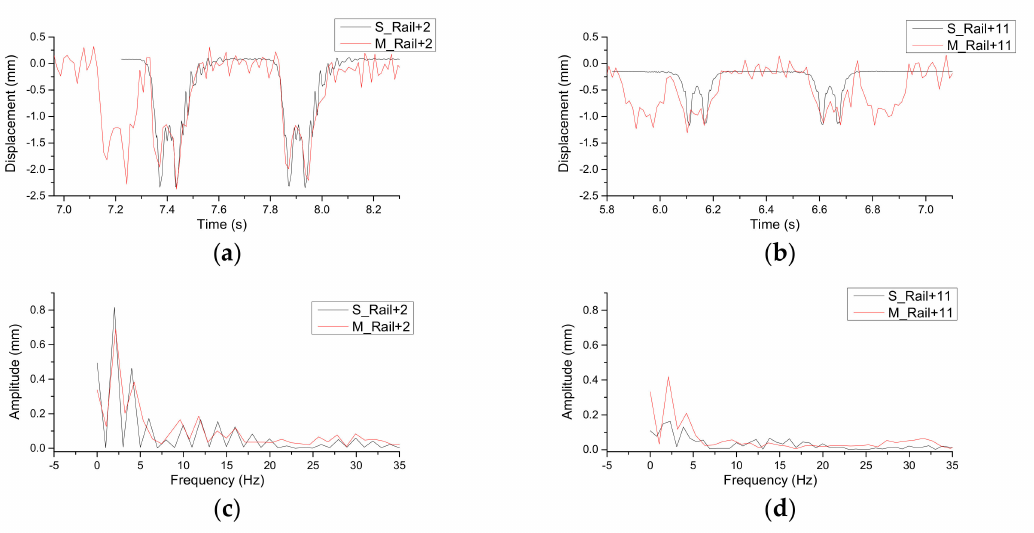
Figure 12. Comparisons of measurement and simulation results: ( a ) the rail close to the bridge in the time domain; ( b ) the rail far from the bridge in the time domain; ( c ) the rail far from the bridge in the frequency domain; and, ( d ) the rail close to the bridge in the frequency